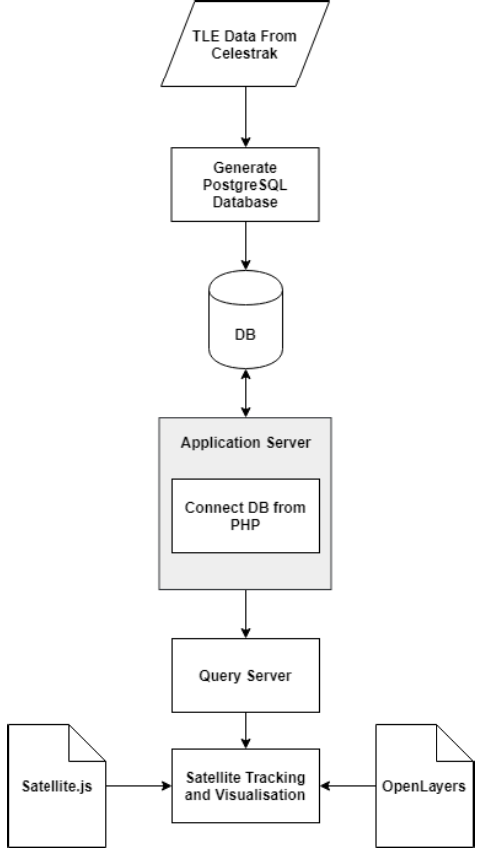
Figure 1: Schematic and Inter-process flow of the Proposed